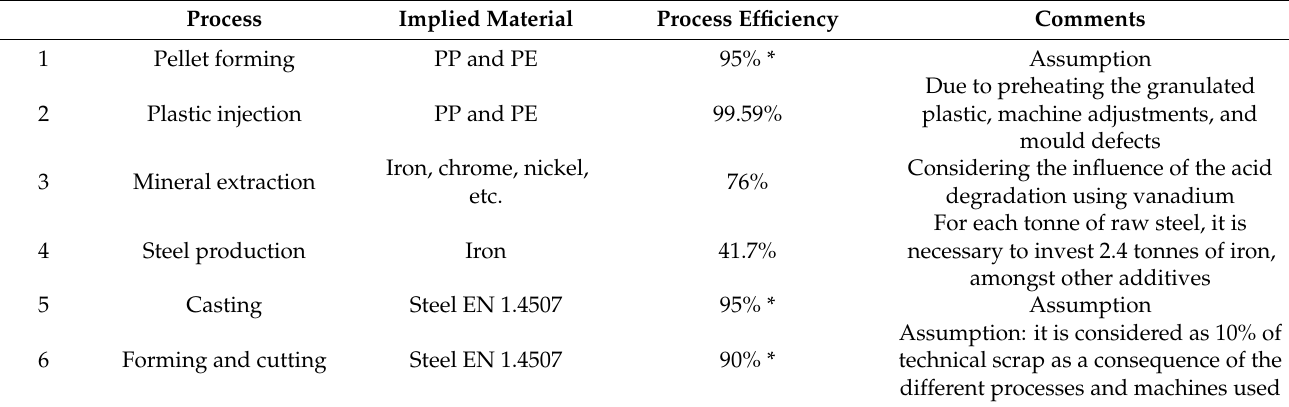
Table 25. Process efficiency of the main material-consuming and energy-demanding processes involved in the analyzed product’s production [77–79].